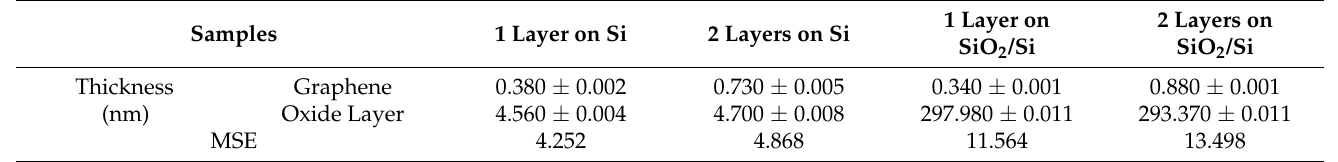
Figure 3. Variable angle spectroscopic ellipsometry of graphene on Si and on SiO 2 /Si substrates at room temperature. the measured (black line) and fitting (red dot) psi( ψ ) and delta( Δ ) spectra for the monolayer graphene on Si substrate [( a ) and ( b )] and on SiO 2 /Si substrate [( c ) and ( d )], [( e ) and ( f )] represent the extracted refractive indices (n) and the extinction coefficients (k) by SE fitting. Table 1. Thicknesses and mean squared error (MSE) values of graphene samples.